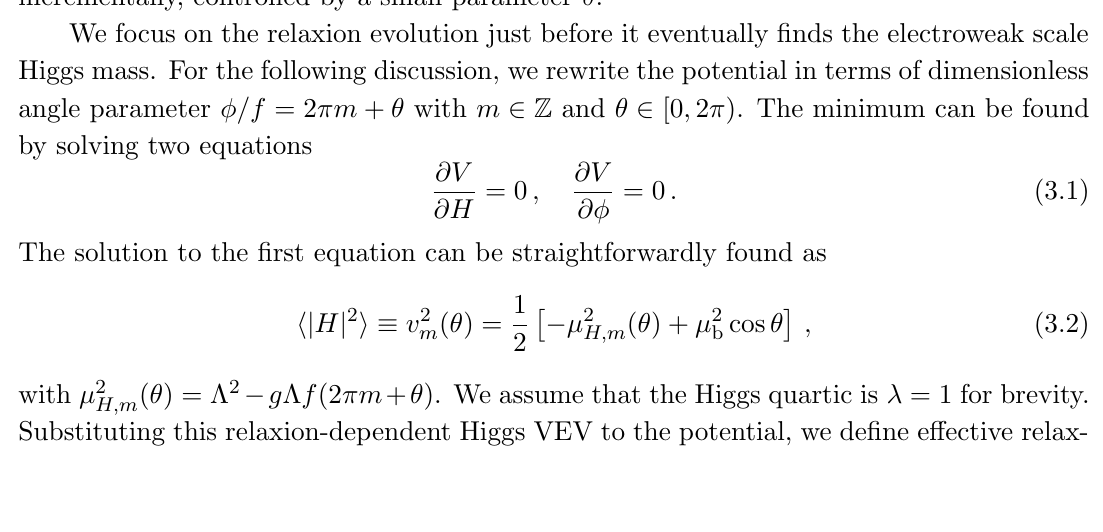
cos (cid:18) 0 1. For more information, see (cid:24) (cid:24)